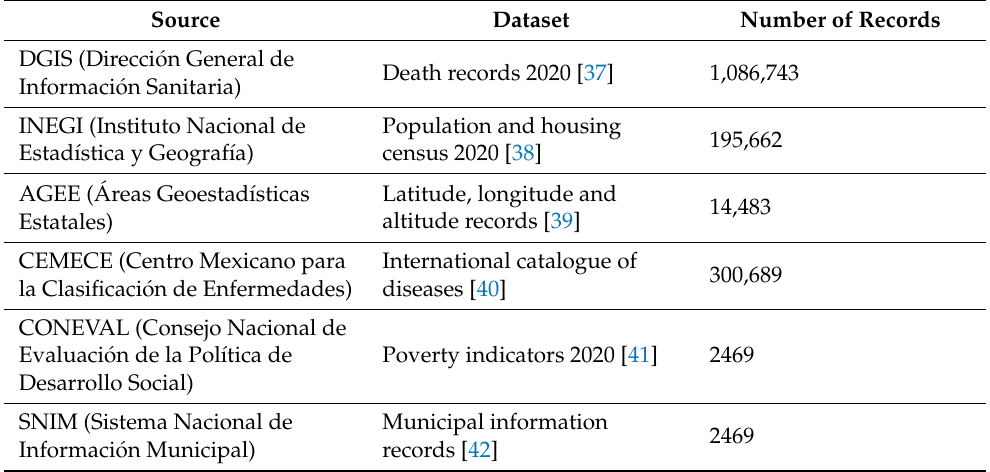
Table 1. Data source and its official source.